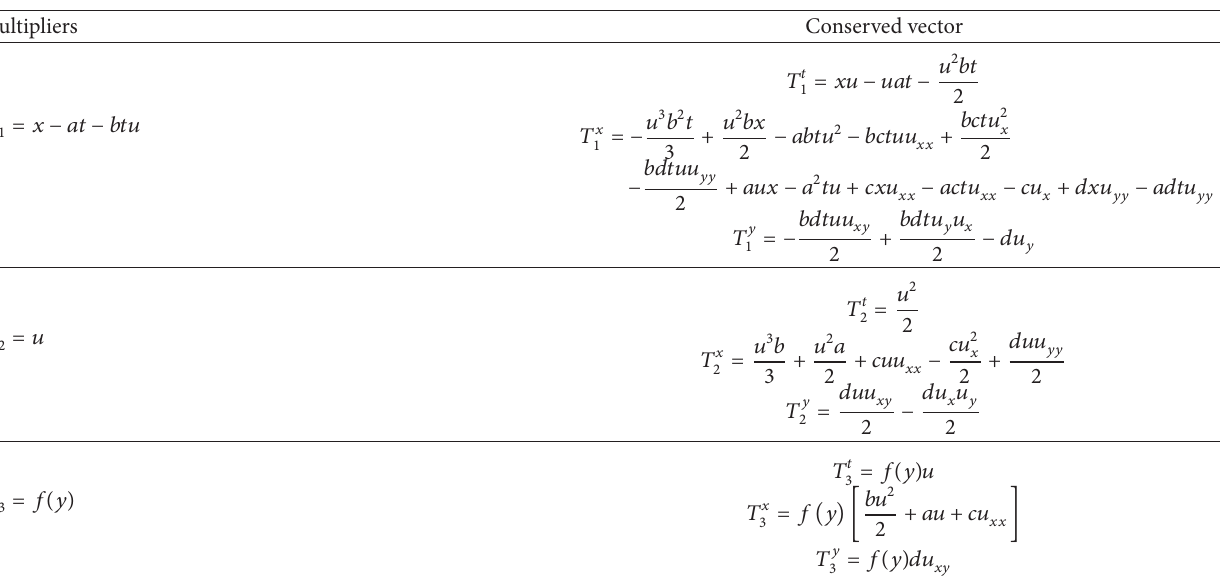
Table 1: Multipliers and conserved vectors for